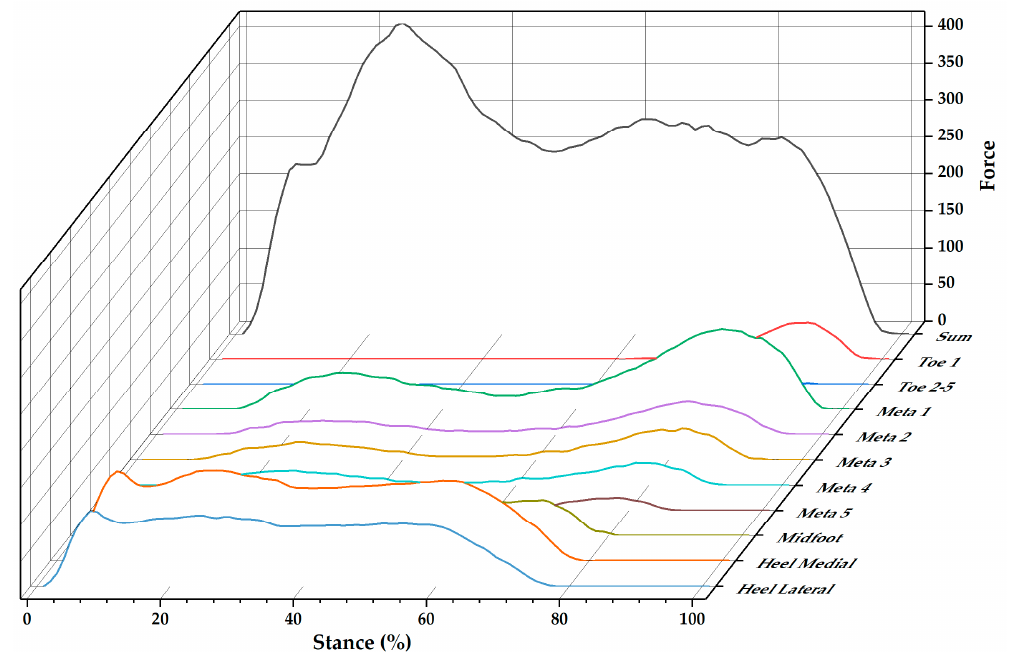
Figure 2. Example of regional and sum ground reaction forces during walking. The calculation of foot balance index ( FBI ) is based on the mean value of peak pres- sure in metatarsal joints and the heel regions, which is presented in Equation (1). FBI presents total foot stability with the positive value indicating foot pronation and the negative value indicating foot supination [28,33]: